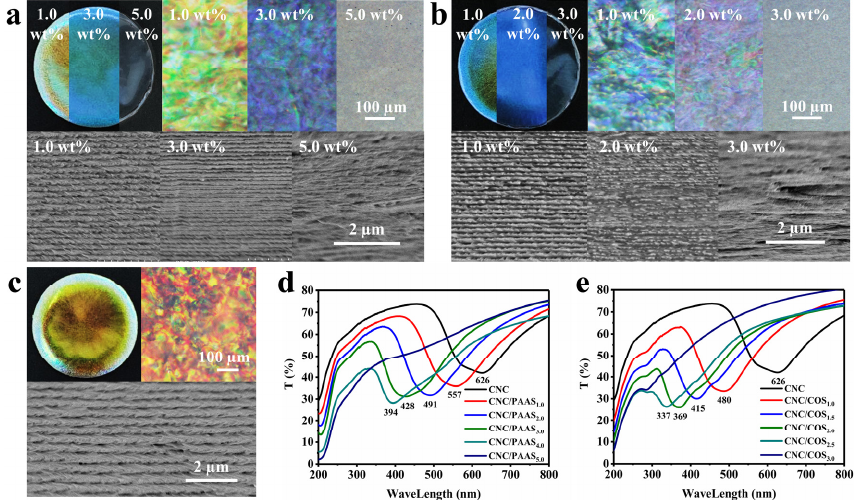
Figure 1. The optical photographs ( top left ), POM patterns ( top right ), and SEM images ( below ) of ( a ) CNC/PAAS films (the ratio of PAAS is 1.0 wt%, 3.0 wt%, and 5.0 wt%, respectively), ( b ) CNC/COS films (the ratio of COS is 1.0 wt%, 2.0 wt%, and 3.0 wt%, respectively), and ( c ) pure CNC film. The UV spectrums of ( d ) CNC/PAAS films and ( e ) CNC/COS